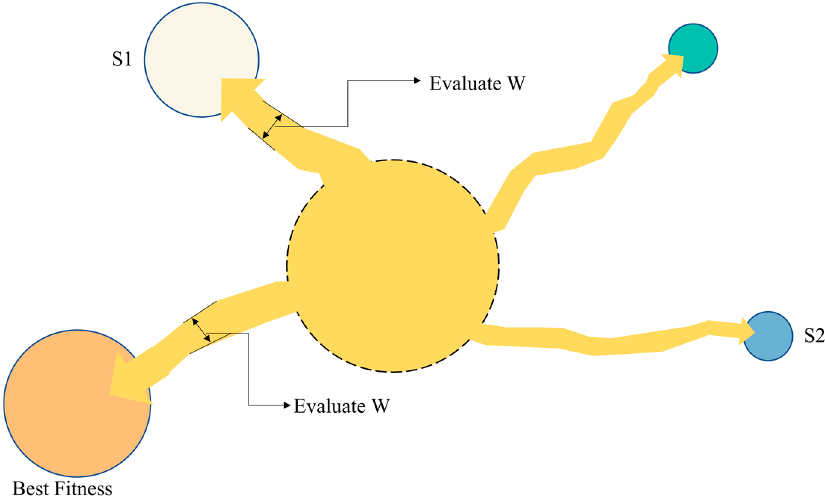
Figure 4. Process adjusts to